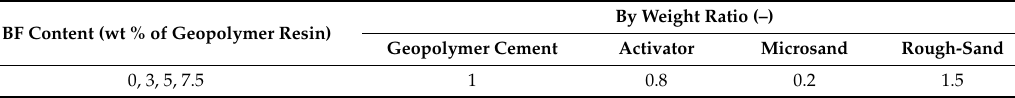
Table 2. Mixture of geopolymer mortar